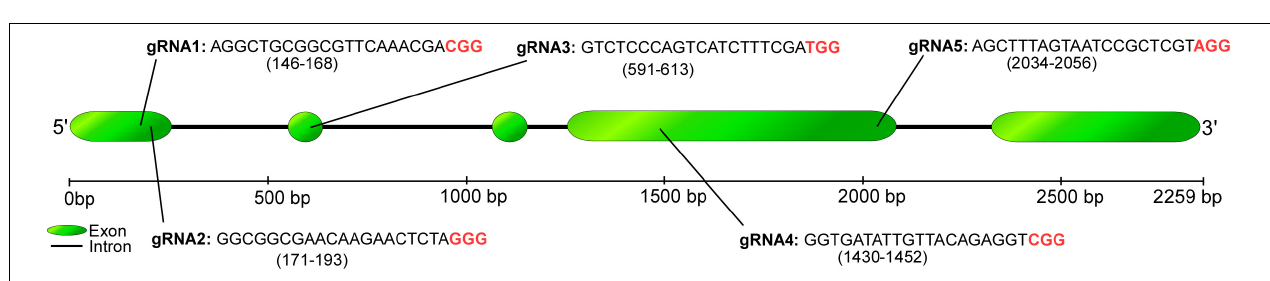
FIGURE 2 | Schematic representation of the GmCPR5 locus and design of gRNAs. The location of target sites was shown by engineered gRNAs 1, 2, 3, 4, and 5 along with their sequences. The PAM motifs are indicated in red.